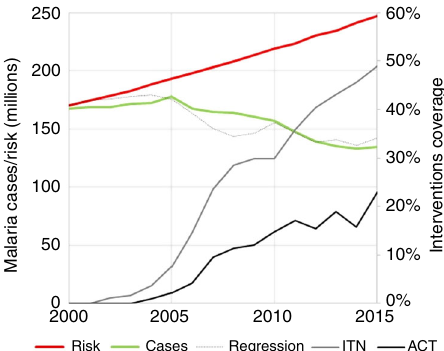
Fig. 5 Malaria incidence data over the 2000 – 2015 time period. Multiple regression (black dotted curve) of malaria incidence data (green) over the 2000 – 2015 time period, as a function of tree cover loss, the proportion of populations at risk using ITN (grey), and the proportion of populations at risk using ACT (black). Overall malaria risk (red) is determined by evaluating the multiple regression formula for existing tree cover loss, but assuming zero usage of ITN and ACT 64, 89 . Considering the high R 2 of the regression, we attribute the difference between the red and the green curves to